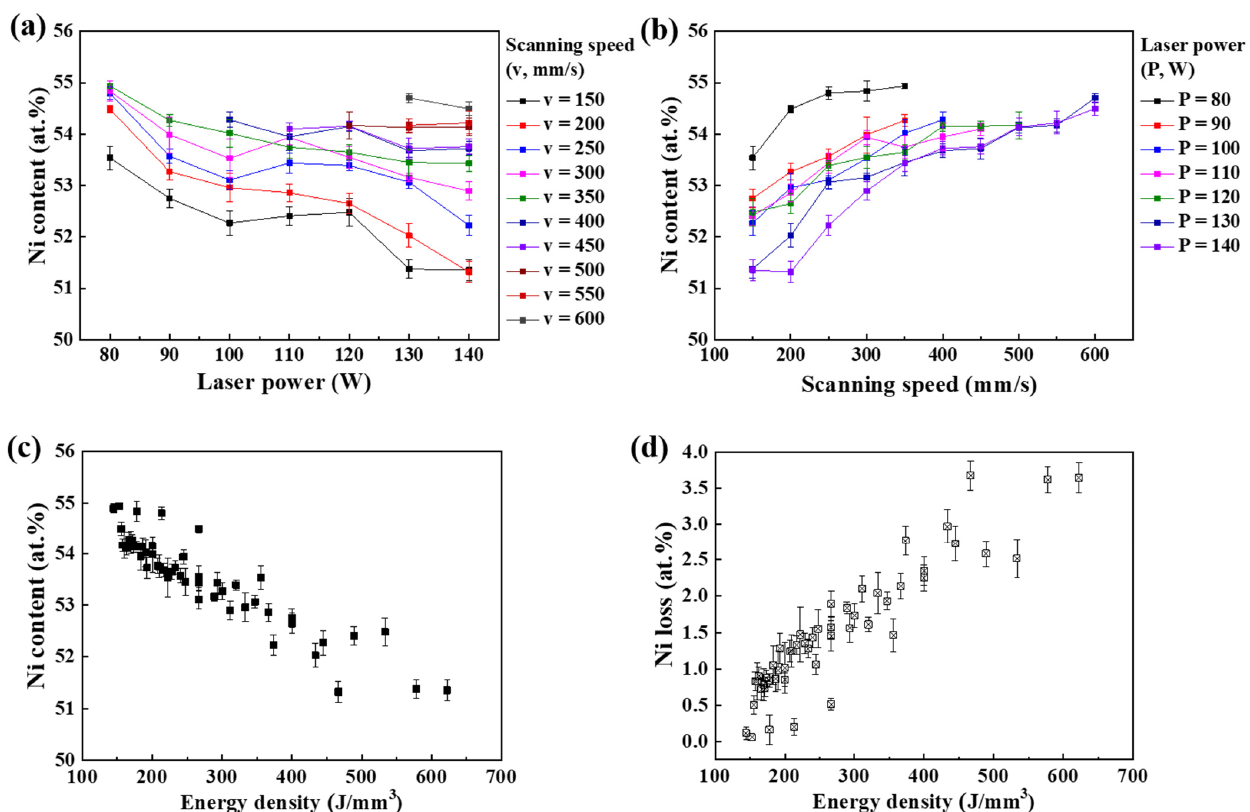
Figure 4. Ni content of SLM 60NiTi as a function with processing parameters: ( a ) laser power; ( b ) scanning speed; ( c ) energy density; ( d ) Ni loss as a function with energy density.